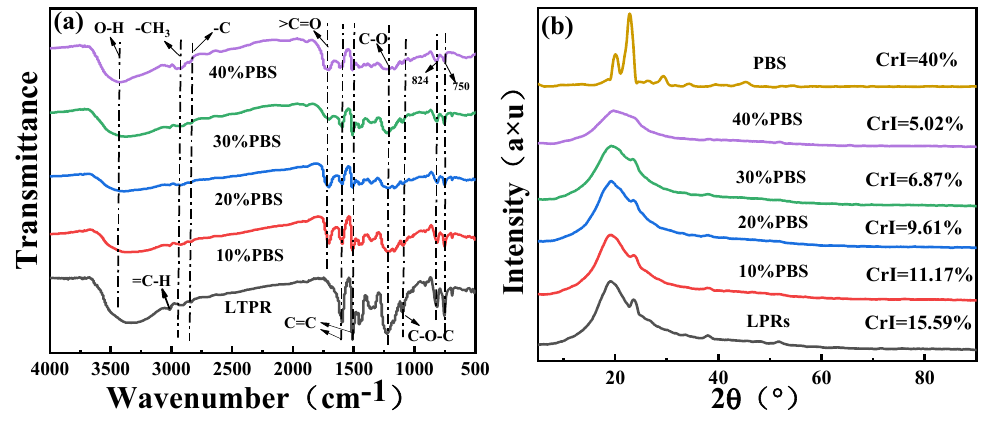
Figure 3. ( a ) FTIR spectra. ( b ) XRD spectra.